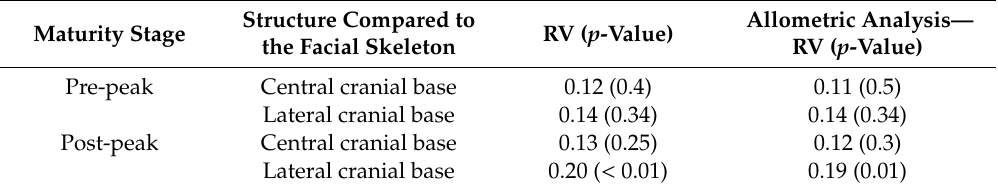
Table 2. Values of the overall correlation (RV) for the Partial Least Square (PLS) analyses and the results of the permutation test ( p -value).